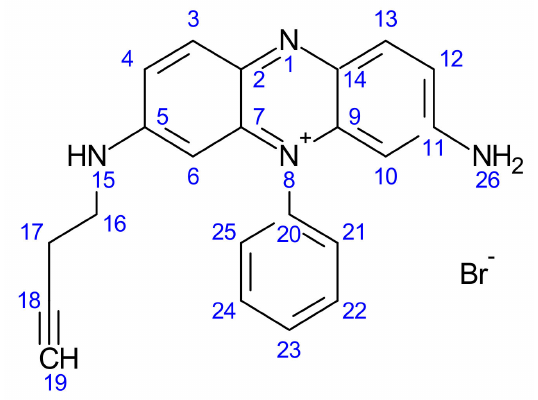
Figure 8. Structure of but-3-yn-1-yl 3,7-diamino-5-phenylphenazin-5-ium bromide